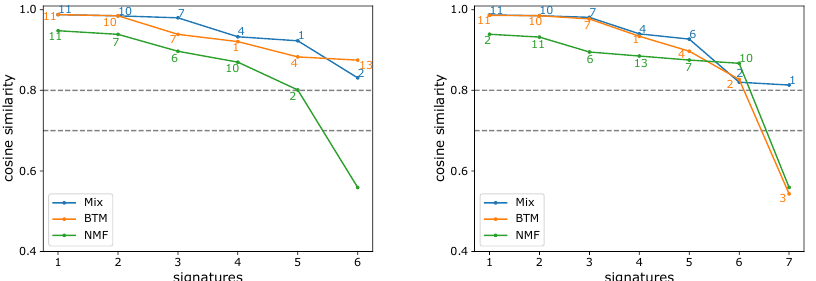
Figure 6. De novo signature discovery of MSK-IMPACT panel data. Shown are the sorted cosine similarities between learned signatures and most similar COSMIC signature (denoted next to the plot) for Mix , Btm , and NMF, across a range of number of signatures (6, 7 corresponding to ( left ) and ( right ), respectively). Repeating signatures of the same model are not